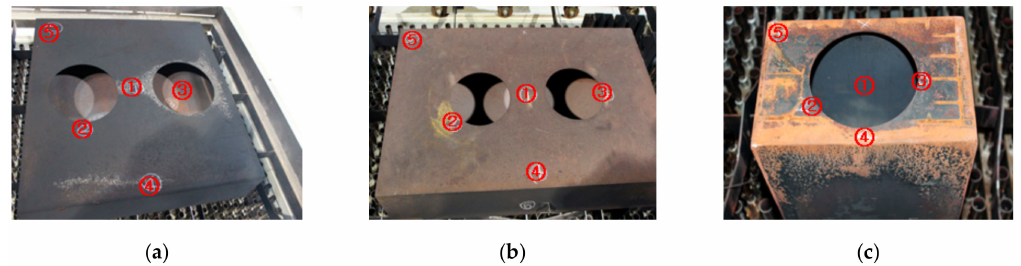
Figure 14. Shape of mock-ups and their temperature measurement points: ( a ) large mock-up; ( b ) medium-sized mock-up; ( c ) small